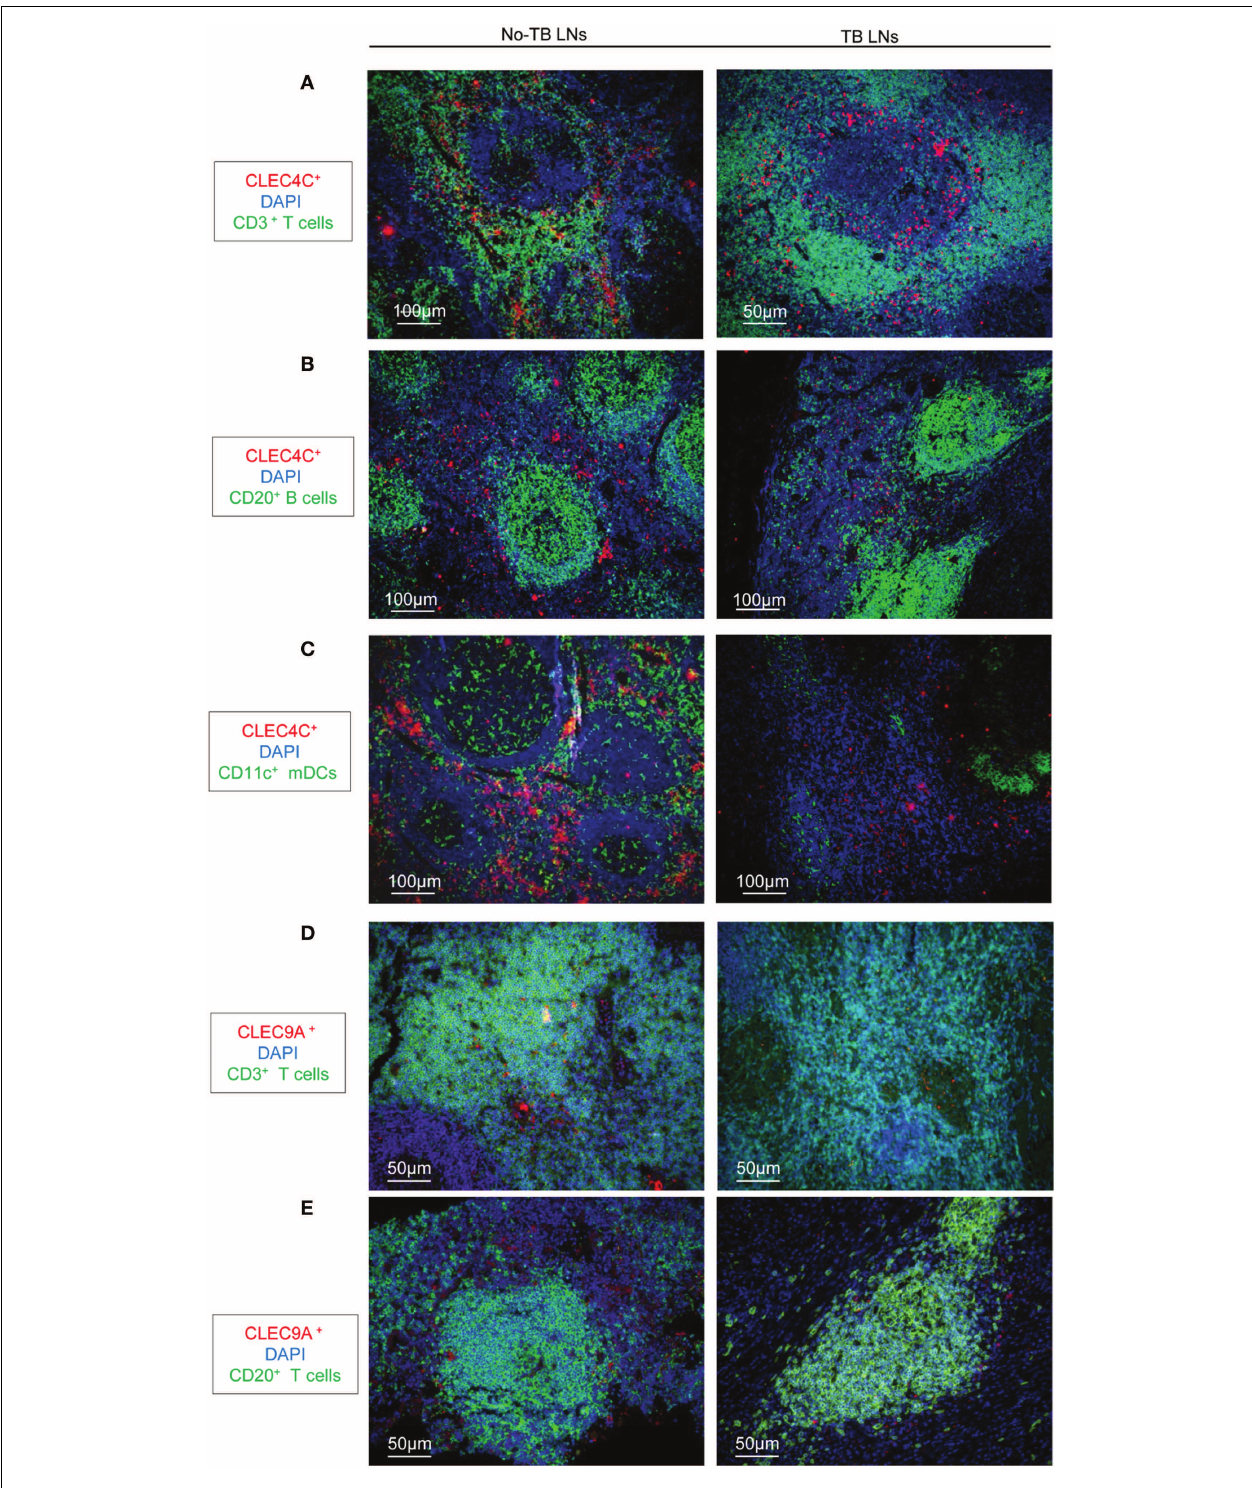
FIGURE 1 | Immunostaining of DCs in LNs fromTB patients and individuals withoutTB . (A–C) Immunostaining of pDCs (CLEC4C, red) and (A) T cells (CD3 + , green); (B) B cells (CD20 + , green); (C) CD11c + cells (green). DAPI (blue) indicates cell nuclei. (D,E) Immunostaining of CD141 hi DCs (CLEC9A, red); and